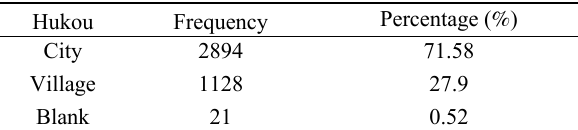
Table 7 Descriptive analysis of hukou status